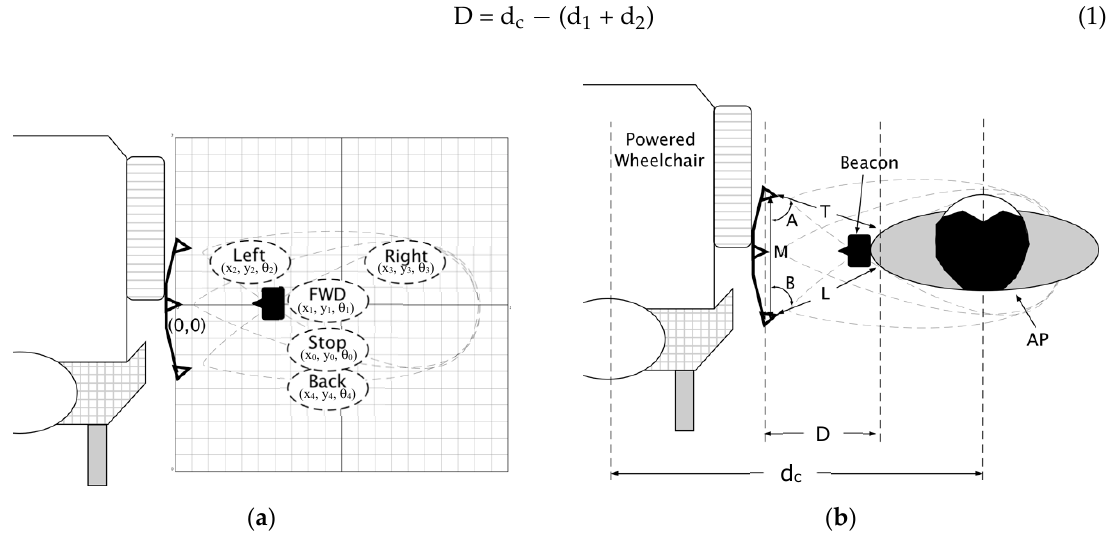
Figure 3. ( a ) AP position in coordinate space beside the wheelchair. x and y represent location coordinates and θ is the angle of a line from the origin to the point x, y. ( b ) Relationship between the AP conversation distance (d c ) and tether distance (D).